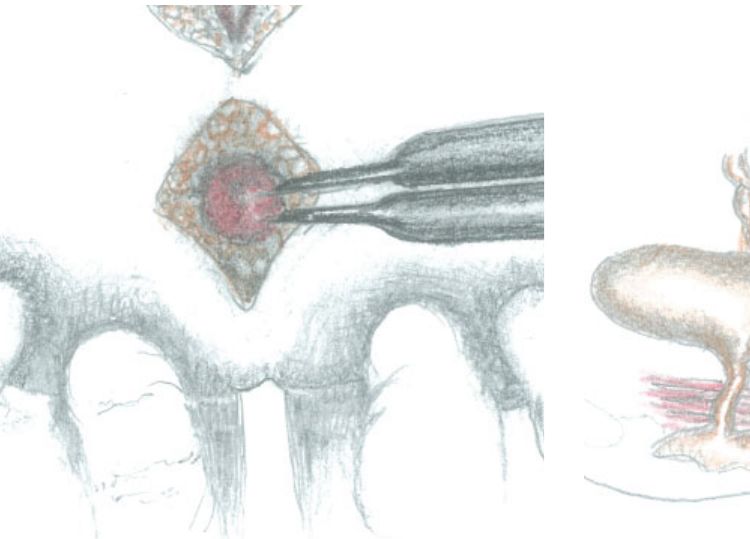
Fig. 5 The center of the sphincter complex is de fi ned using a neurostimulator.